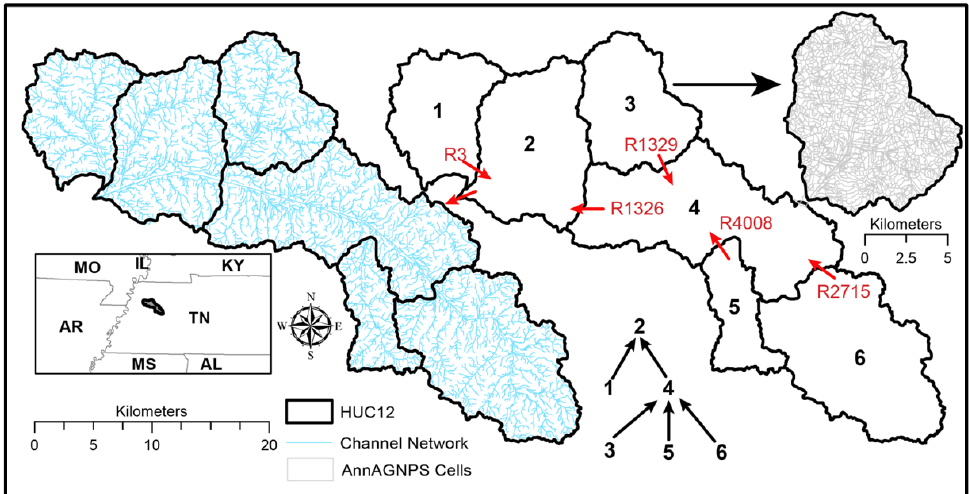
Figure 2. Watershed selected for evaluation of the AnnAGNPS ITEAMS simulation alternative. The watershed (HUC10) is composed of six sub-watersheds (HUC12s). The six sub-watersheds were discretized into 12,581 AnnAGNPS cells. Red arrows indicate selected AnnAGNPS reaches that link flow between HUC12s.